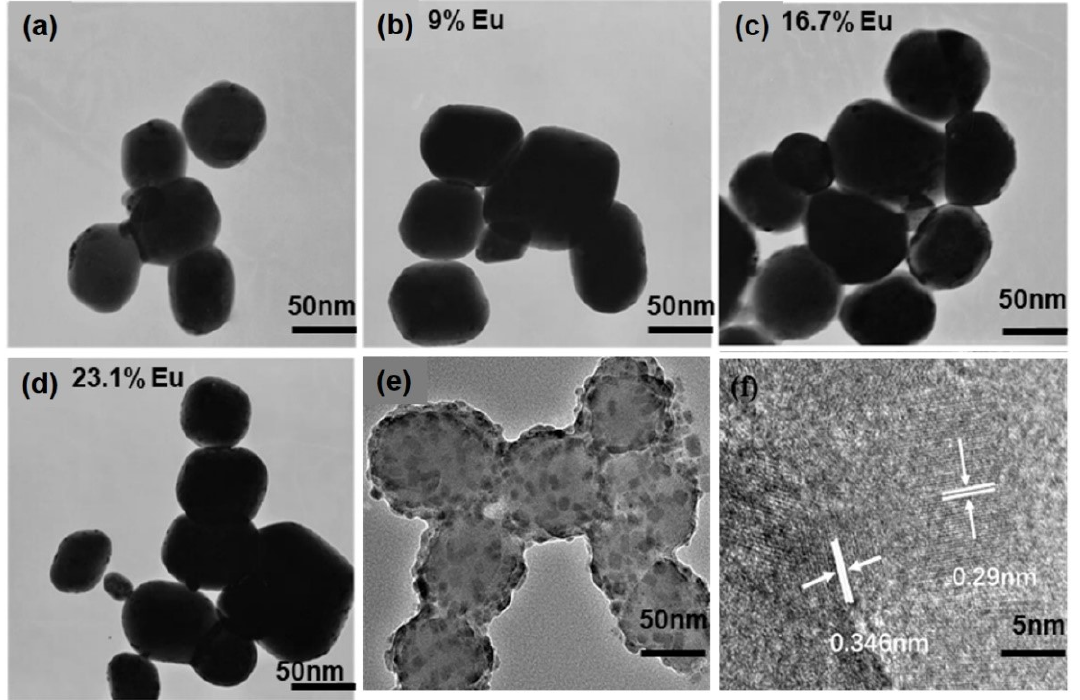
Figure 2. TEM images of ( a ) Undoped CsPbBr 3 /Cs 4 PbBr 6 and ( b – d ) CsPbBr 3 /Cs 4 PbBr 6 :Eu 3+ composite with different Eu 3+ doping concentrations ( e ) Enlarged TEM image of the CsPbBr 3 /Cs 4 PbBr 6 :Eu 3+ composites with an Eu 3+ doping concentration of 16.7% ( f ) HR-TEM image of CsPbBr 3 /Cs 4 PbBr 6 :Eu 3+ composites with an Eu 3+ doping concentration of 16.7%.